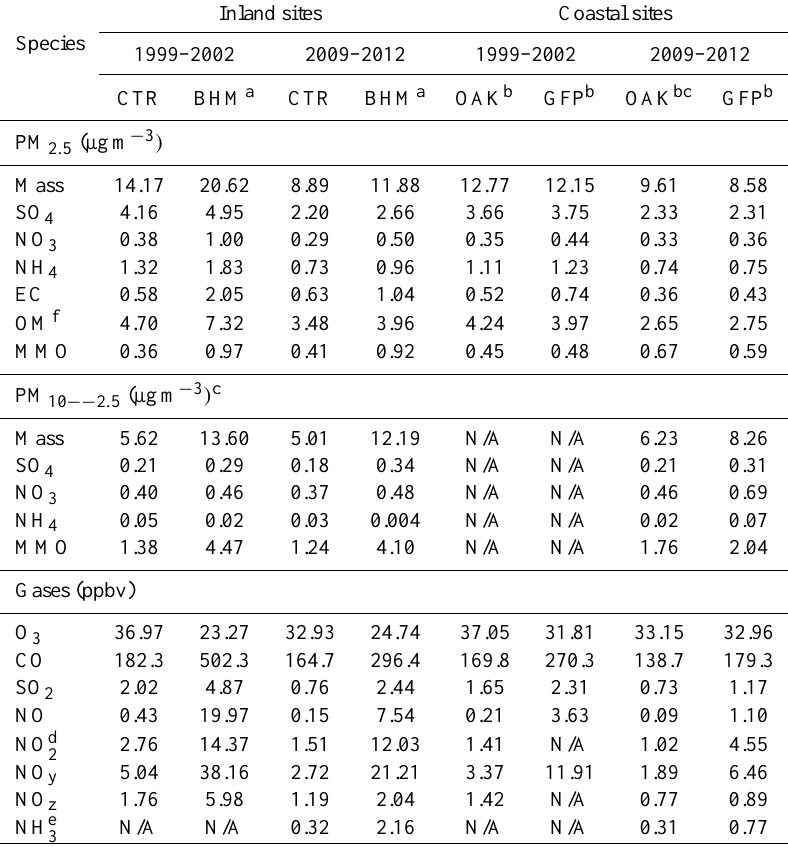
Table 2. Mean concentrations by inland and coastal sites determined for 1999–2002 and 2009–2012. PM 2 . 5 and PM 10 −− 2 . 5 mass and species concentrations are means of daily measurements (24h filter-based samples). O 3 measurements are means of peak daily 8h maxima. Concentrations of gases are means of days determined from hourly data. Means were determined by year, and the yearly means were then